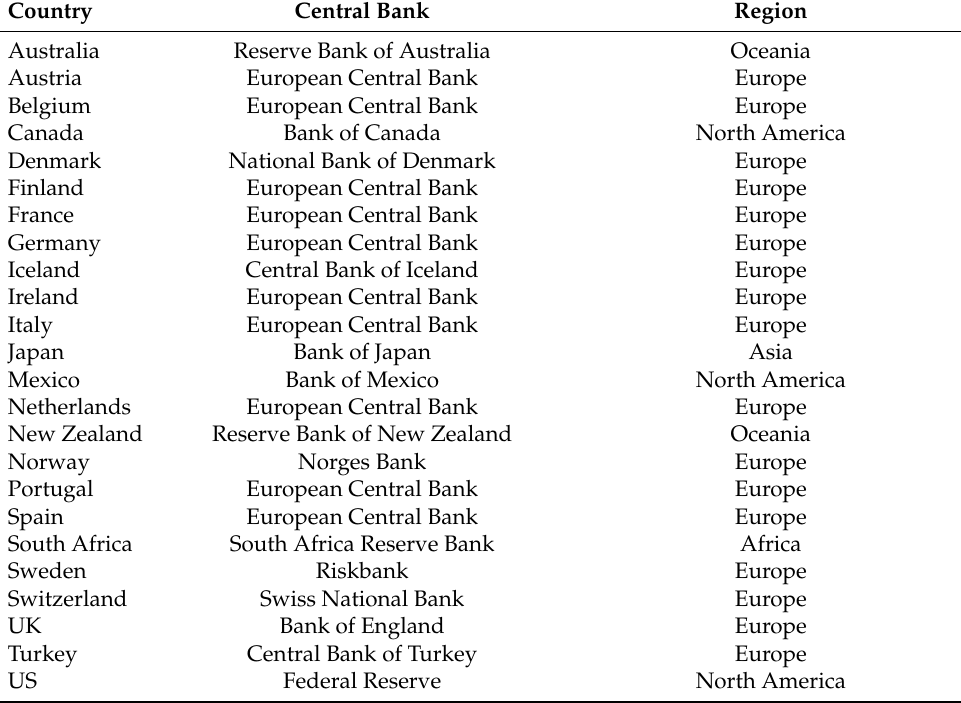
Table A2. Regions and Central